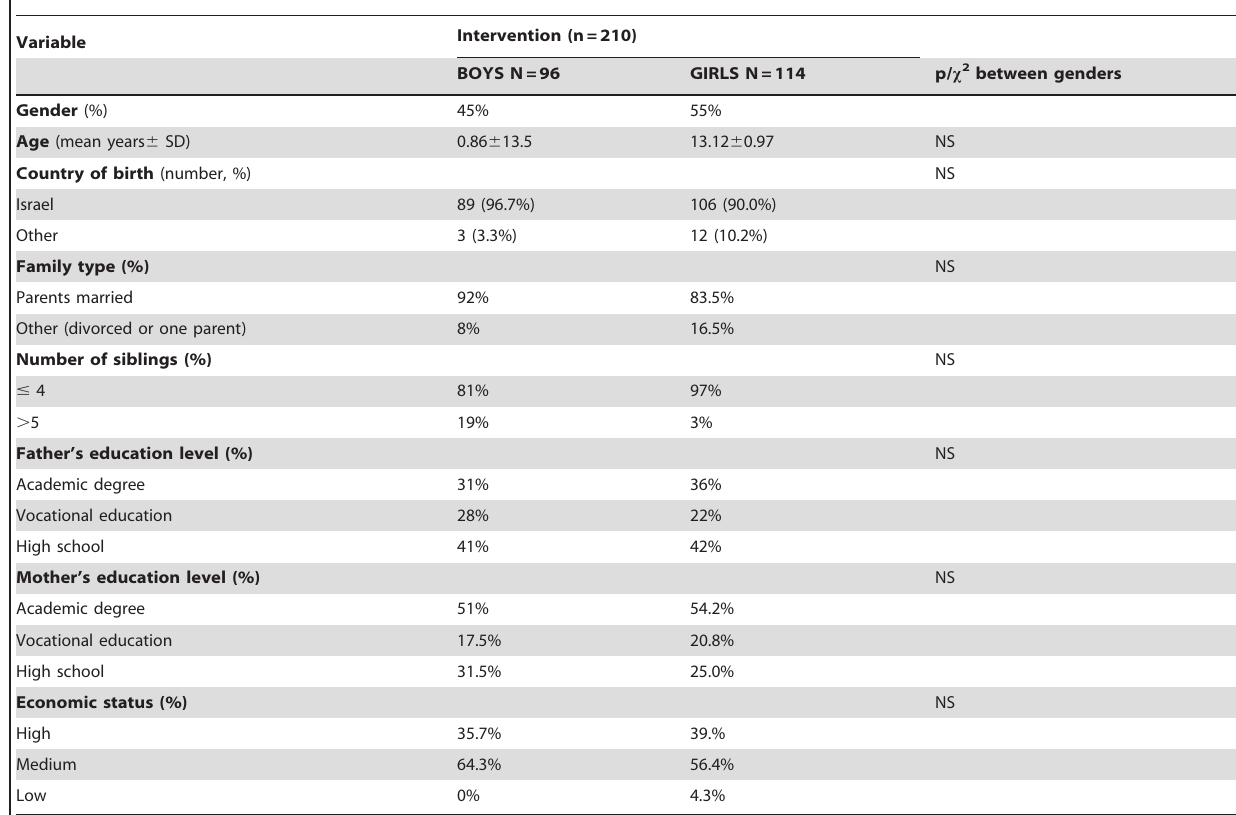
Table 1. Participants demographic data at baseline according to genders.